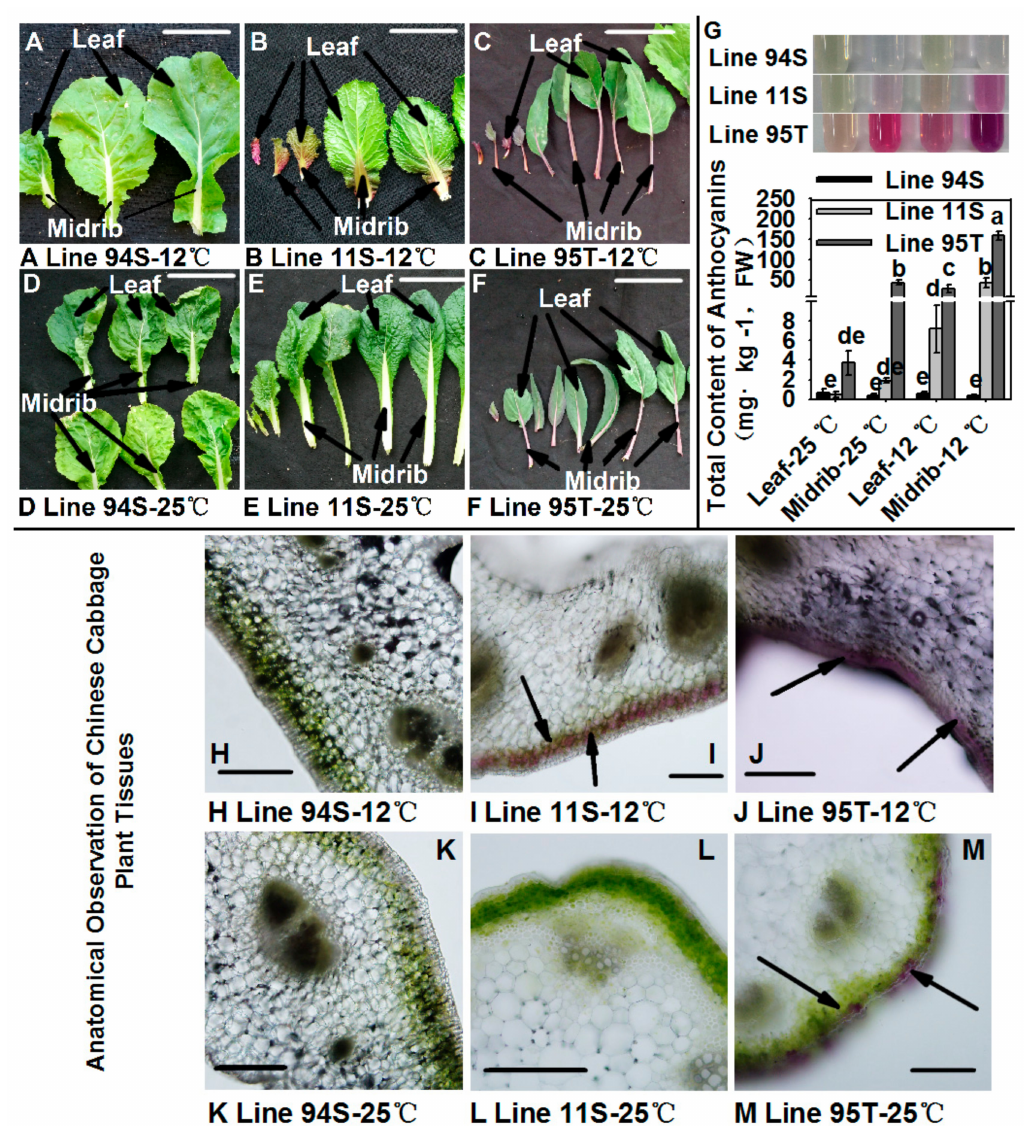
Figure 1. Seedlings of Chinese cabbages under 25 ◦ C and 12 ◦ C conditions. Plants of three lines were grown under a 12-h light photoperiod at 25 ◦ C, 125 mmol m − 2 s − 1 ; 28-day seedlings were put at 12 ◦ C for 15 days, and seedlings that stayed at 25 ◦ C with same light condition were treated as the control. ( A – F ) appearance of individual seedling leaves picked from seedlings of three lines; ( G ) the extract solution of samples (the solution was 1% hydrochloric acid water solution) and the total anthocyanin content of samples; ( H – M ) anatomical observation of leaf midrib tissues. The scale bar is 5 cm and 200 µ m in ( A – F ) and ( H – M ), respectively. Arrowheads indicate anthocyanin